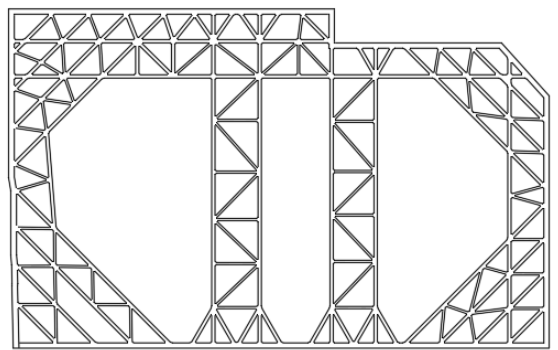
Figure 4. Support layout in section B of the foundation pit.